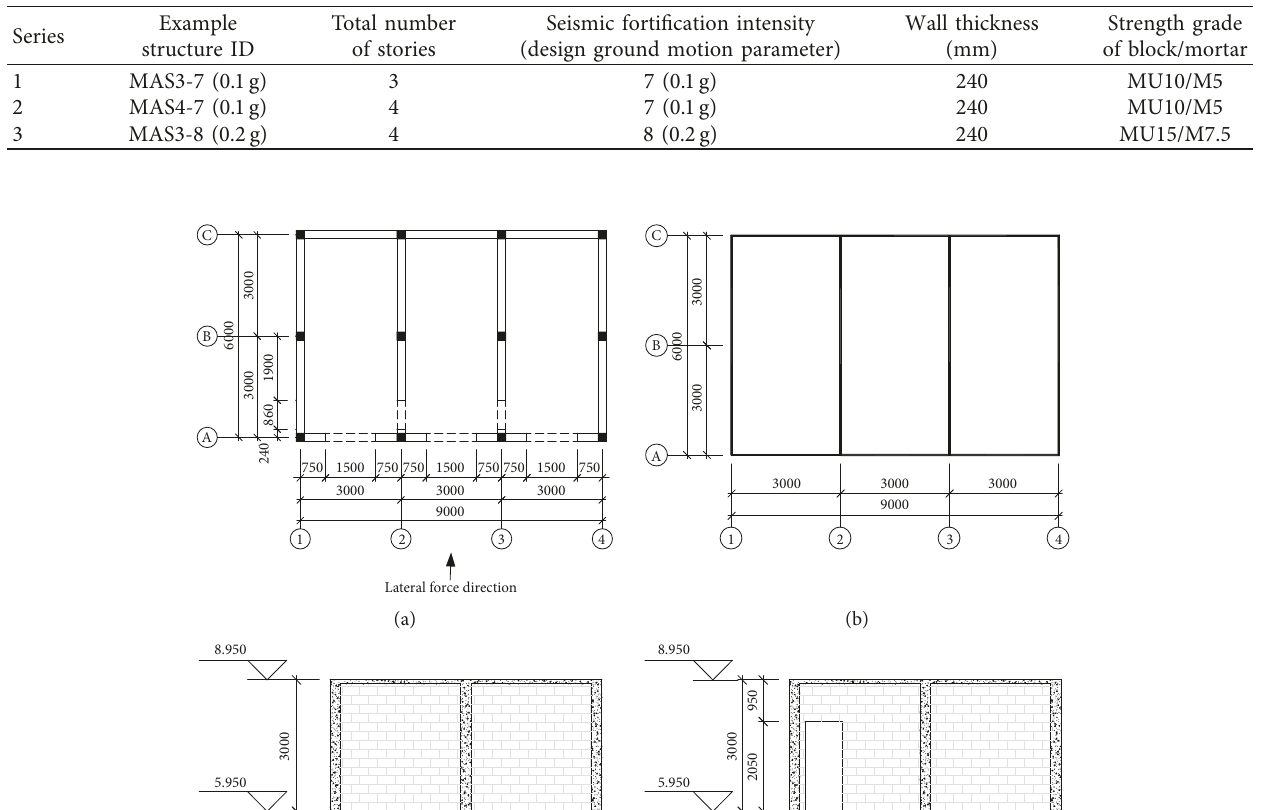
Table 1: Overview of model design